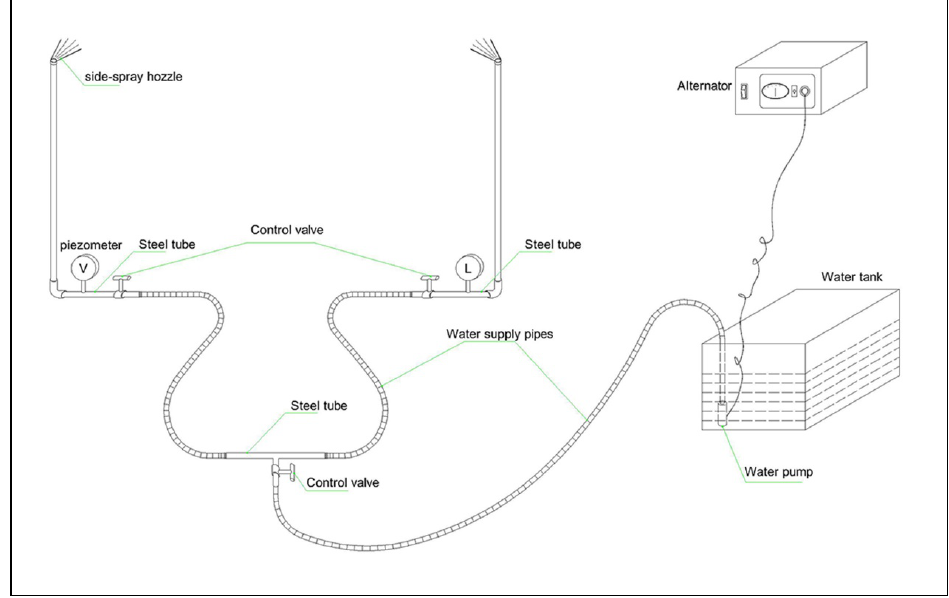
Figure 3. Schematic of the side-spray rainfall simulation system used in the present study.